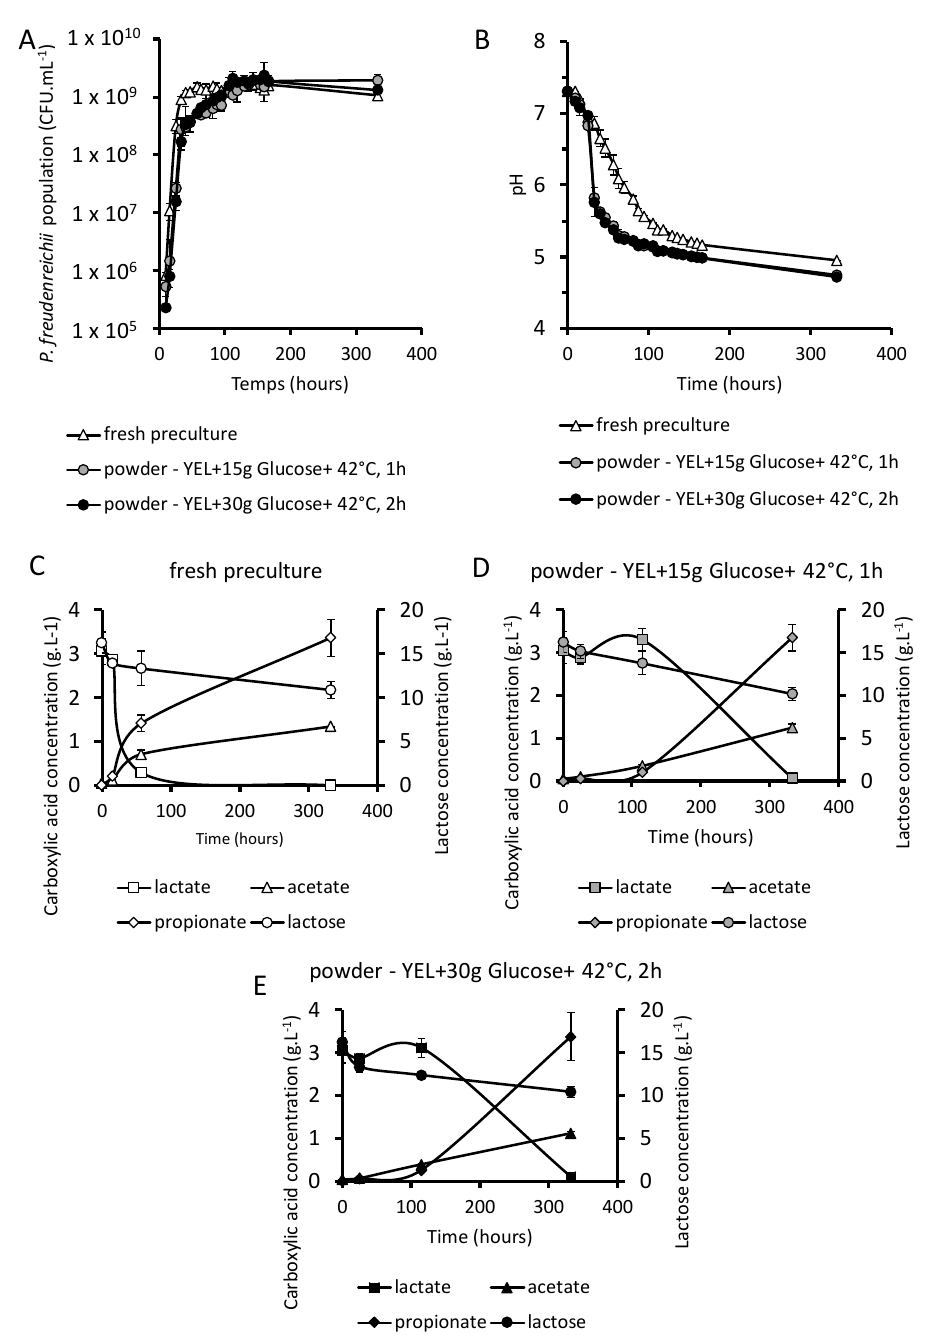
Figure 5. Powders containing P. freudenreichii were used to ferment a cheese-like medium . Powders obtained previously were inoculated in a cheese-like medium. P. freudenreichii growth was monitored by CFU counting in YEL agar plates ( A ) and acidification were followed ( B ). Lactate and lactose consumption, as well as propionate and acetate production, were quantified by HPLC ( C,D,E ) as described in material and methods. Fresh culture: inoculation with P. freudenreichii grown in YEL medium . (YEL + 15 g Glucose + 42 °C, 1 h): inoculation with powders containing P. freudenreichii cultivated in YEL with 15 g . L − 1 of glucose and heat adapted at 42 °C over 1 h before spray drying.